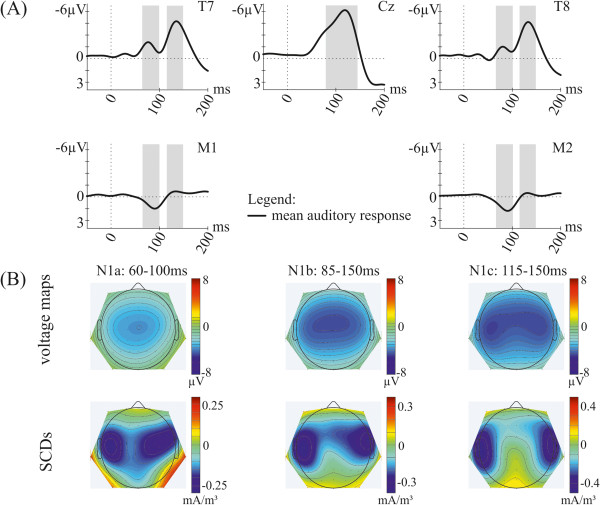
Illustration of the mean auditory response. (A) Grand-average ERPs (mean of attention conditions AS, AM, AV as well as self-initiated and externally-initiated sounds) at temporal and central electrodes and the mastoids. Analysed time windows are marked in grey. (B) Voltage maps and scalp current densities (SCDs) during the latency ranges of the N1a (60–100 ms), N1b (85–150 ms) and N1c (115–150 ms) time window. Note that only part of the baseline is included to the graphs.